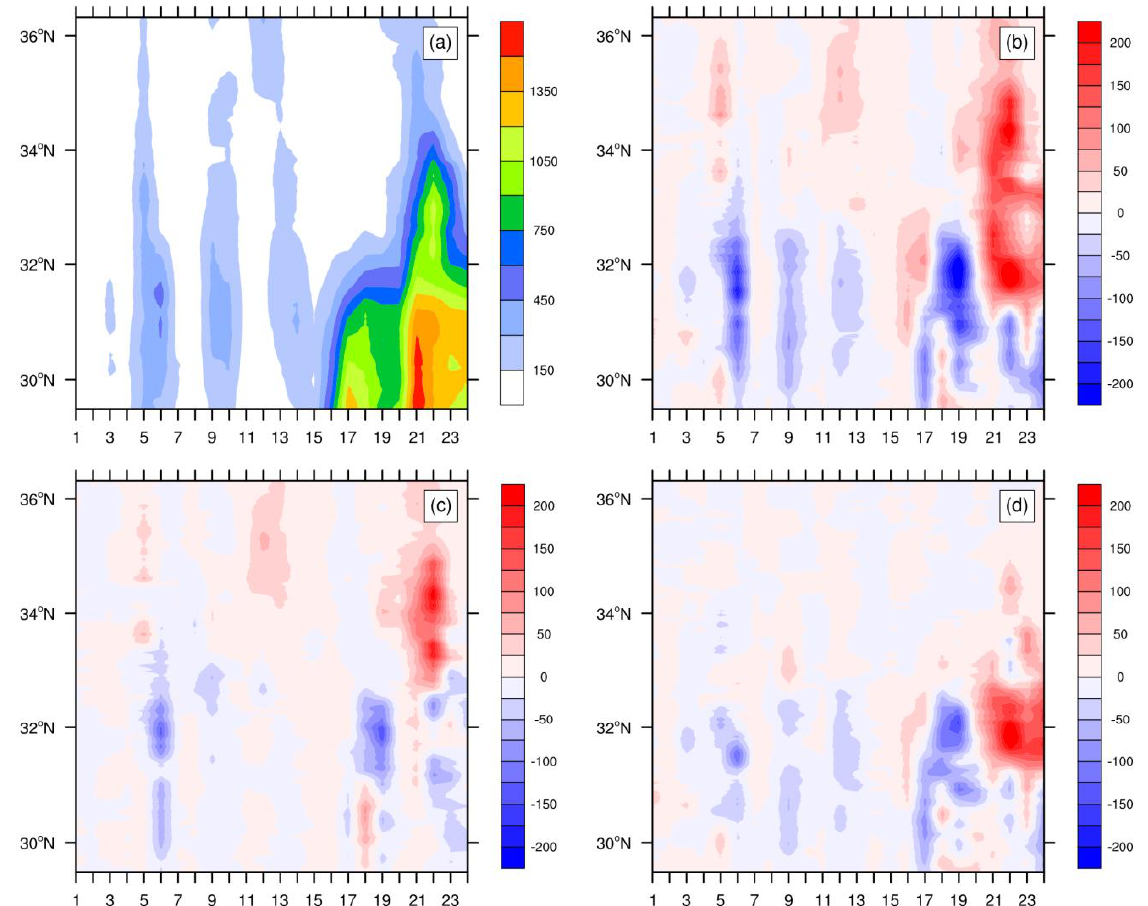
Figure 12. Diurnal-latitude diagrams, where diurnal-latitude diagrams of CAPE (J kg −1 ) averaged in domain 3 in CTRL ( a ). Panels ( b – d ) are the differences ( b ) between LowQD and CTRL (LowQD minus CTRL), ( c ) between LowQ and CTRL (LowQ minus CTRL), as well as ( d ) between LowD and CTRL (LowD minus CTRL), respectively. Blue (red) shading indicates negative (positive) variation.